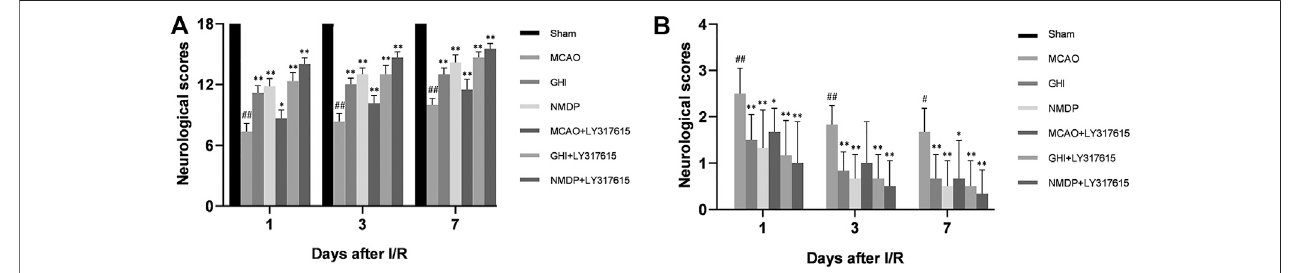
FIGURE 3 | The Garcia neurological score (A) and Longa neurological score (B) in rats for each group ( x ± SD, n (cid:1) 6). #, compared with the Sham group; *, compared with the MCAO group; “ ## ” and “ ** ” means that the p value is less than 0.01; “ # ” and “ * ” means that the p value is less than 0.05.